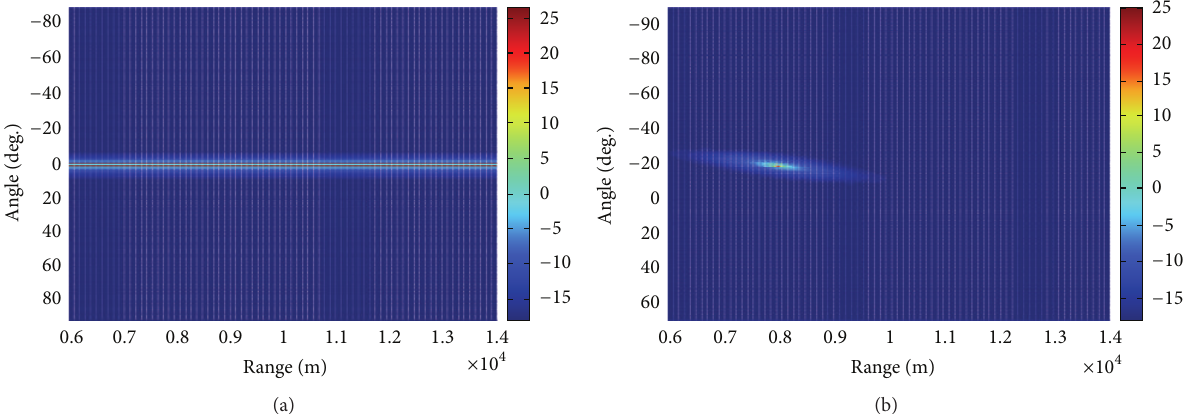
Figure 5: Comparison of estimated parameters of power spectrum. (a) Conventional MIMO radar; (b) FDA MIMO radar.